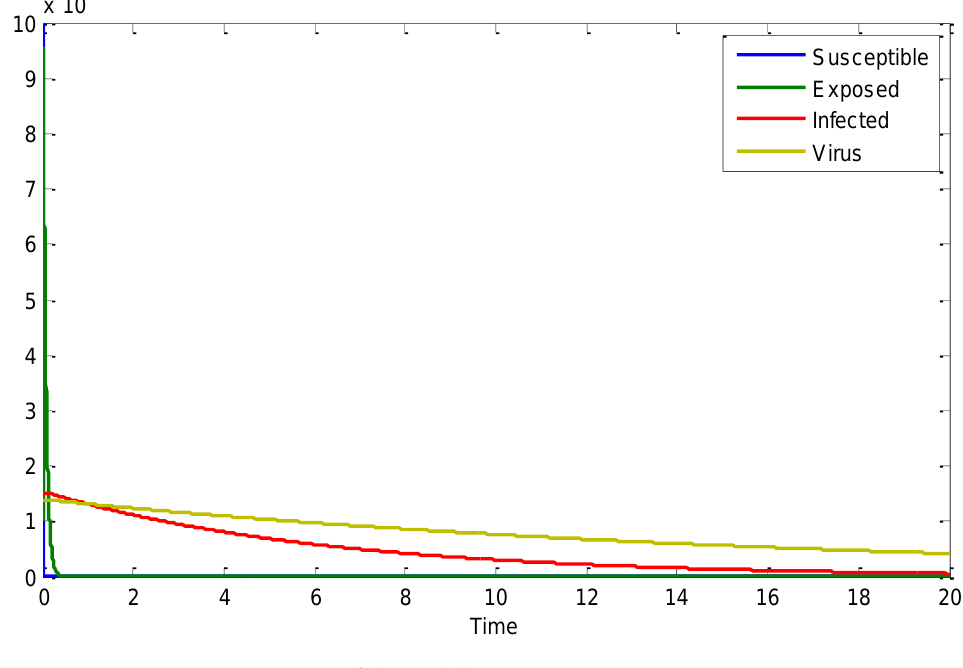
Figure 2. Dynamics of susceptible population without control. From Figure 3, it can be observed that application of shedding effect control in- creases the susceptible population. It is clear that there may be a decrease in the popula-